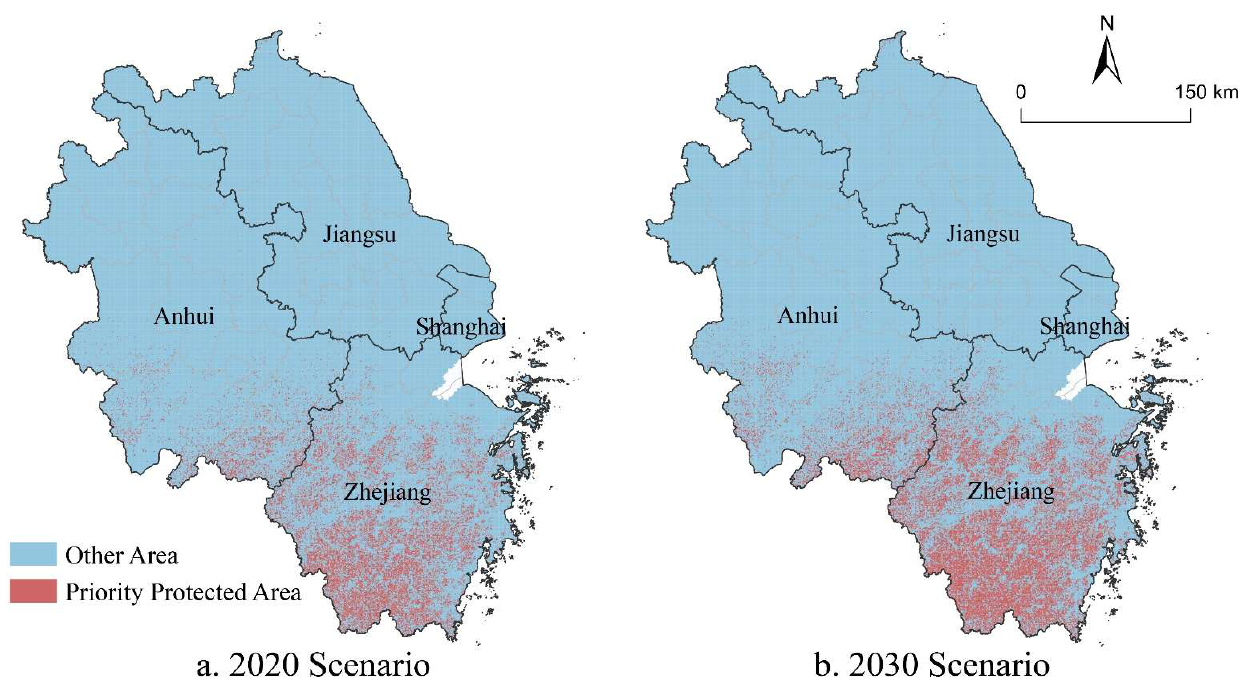
Figure 8. Distribution of priority conservation areas for carbon storage under different scenarios.